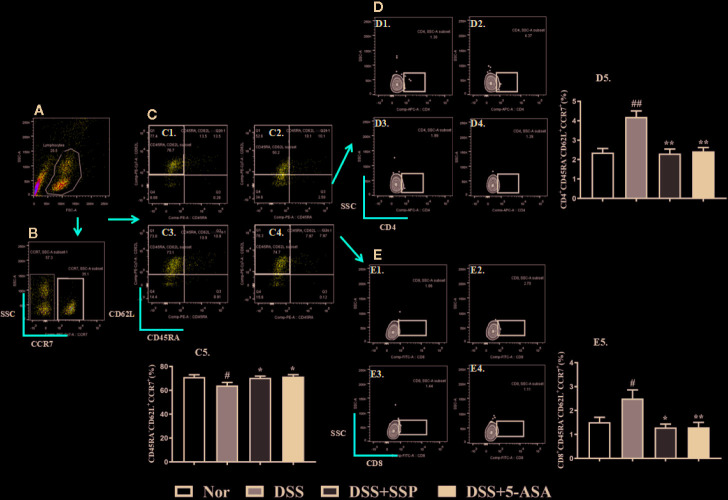
SSP regulated Tcm cells in colitis mice. (A) Total lymphocytes in peripheral blood. (B) CCR7+ lymphocytes were measured by flow cytometry. (C) CD45R- and CD62L-labeled lymphocytes; cells in the left upper side are Tcm cells. C1: Tcm cells in normal group; C2: Tcm cells in DSS group; C3: Tcm cells in DSS + SSP group; C4: Tcm cells in DSS + 5-ASA group; C5: statistical analysis of Tcm cells in the four groups. (D) CD4+ Tcm cell distribution analyzed by flow cytometry. D1: CD4+ Tcm cells in normal group; D2: CD4+ Tcm cells in DSS group; D3: CD4+ Tcm cells in DSS + SSP group; D4: CD4+ Tcm cells in DSS + 5-ASA group; D5: statistical analysis of CD4+ Tcm cells in the four groups. (E) CD8+ Tcm cell distribution analyzed by flow cytometry. E1: CD8+ Tcm cells in normal group; E2: CD8+ Tcm cells in DSS group; E3: CD8+ Tcm cells in DSS + SSP group; E4: CD8+ Tcm cells in DSS + 5-ASA group; E5: statistical analysis of CD8+ Tcm cells in the four groups. Data are presented as mean ± SEM (n = 10). #p < 0.05 and ##p < 0.01 versus normal group; *p < 0.05 and **p < 0.01 versus DSS group.